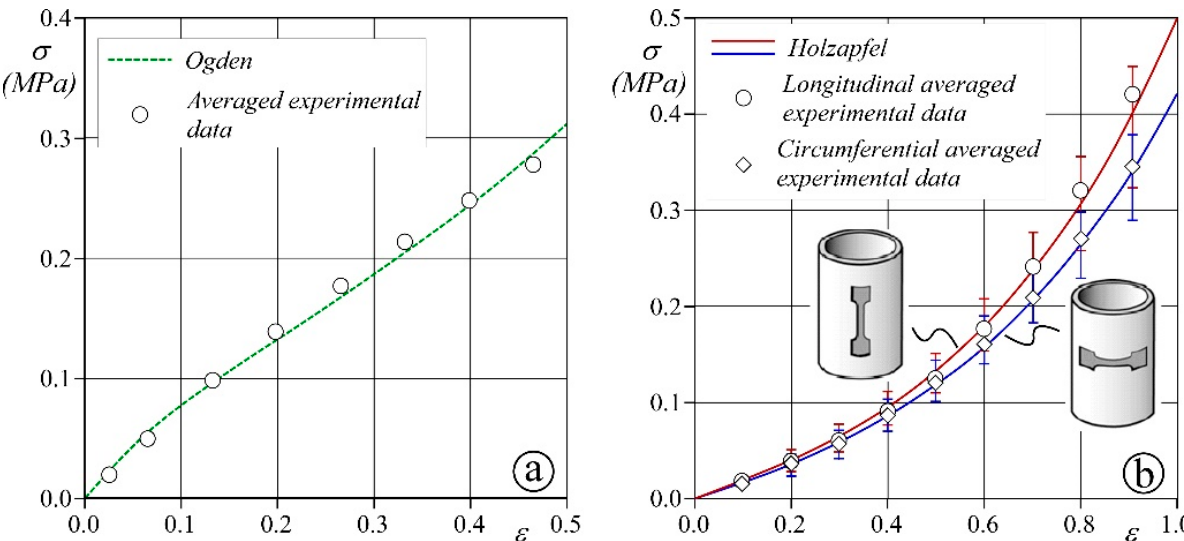
Figure 4. Constitutive model characterization of the Ogden (dashed green line, panel ( a )) and Holzapfel (red and blue solid line for the longitudinal and circumferential direction, respectively, panel ( b )) models. ( a ) The white circles show the average experimental data of biaxial stress tests of 5 samples of PROCHIMA Cristal Rubber silicone. ( b ) The white circles and white diamonds show the averaged experimental data of 4 tensile stress tests of porcine tissues along the circumferential and longitudinal directions, respectively. Red and blue bars show the maximum and minimum stress measured in the experiments to the longitudinal and circumferential direction, respectively. Table 1. Estimates of the parameters for the silicone (Ogden model, Equation (1)) and the biological tissue (Holzapfel model, Equations (2) and (3)).